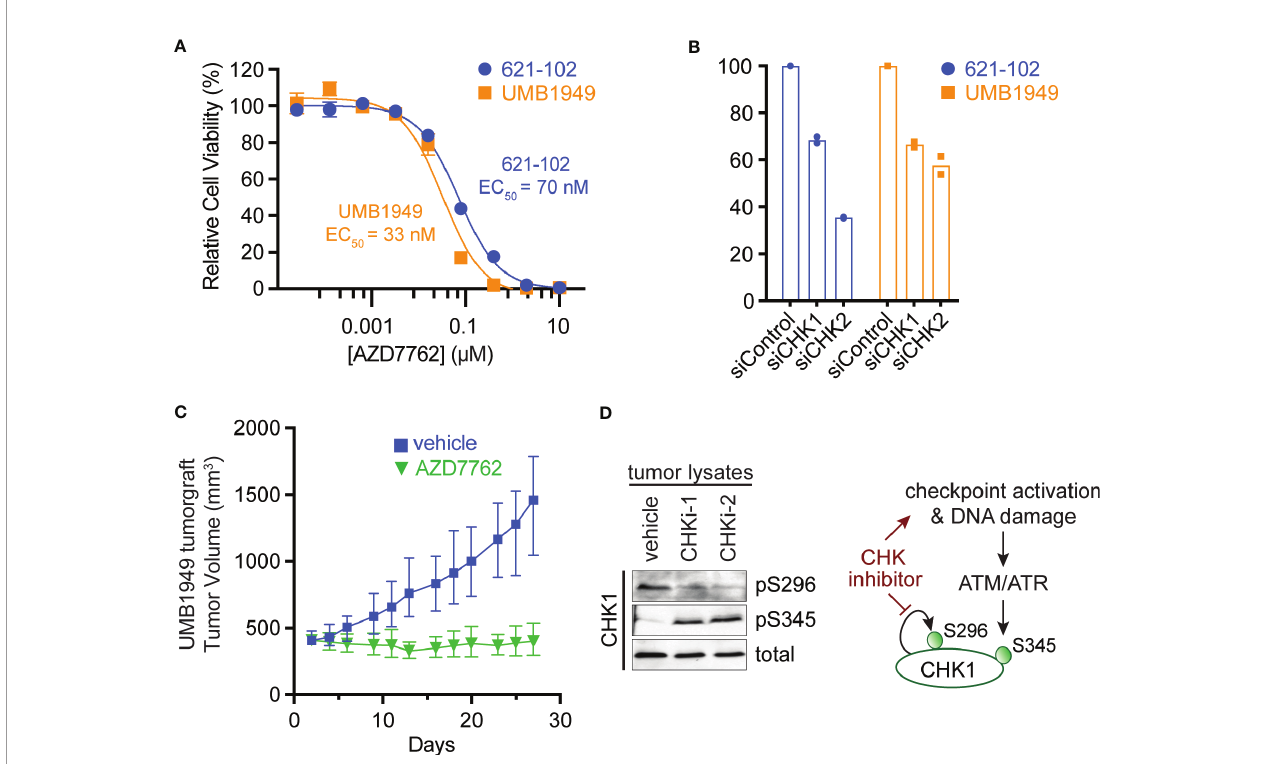
FIGURE 2 | Antitumor ef fi cacy of CHK1/2 inhibitors in patient-derived TSC2-de fi cient tumors. (A) Dose – response curves for AZD7762 in 621-102 or UMB1949 cell lines after 72 h of treatment. Data are presented as mean ± s.e.m. (n = 3) after normalization to control, and the best fi t EC 50 is indicated. (B) Relative viability measurements of 621-102 or UMB1949 cells 72 h after siRNA knockdown of either CHK1 or CHK2. (C) UMB1949 cell line tumorgraft tumor volume in NSG mice. After tumors reached 400 ± 25 mm 3 in volume, mice were treated (i.p. injection) 5× per week with either vehicle (n = 9) or AZD7762 (12.5 mg/kg, n = 9); data presented as mean ± 95% con fi dence interval. (D) Western blot of tumor lysates from UMB1949 tumorgrafts treated with either vehicle or AZD7762. Lysates were probed for phospho-markers of CHK1 (pS296 and pS345) and total CHK1 used as loading control; CHKi-1 and CHKi-2 indicate two AZD7762-treated tumors from panel (C)